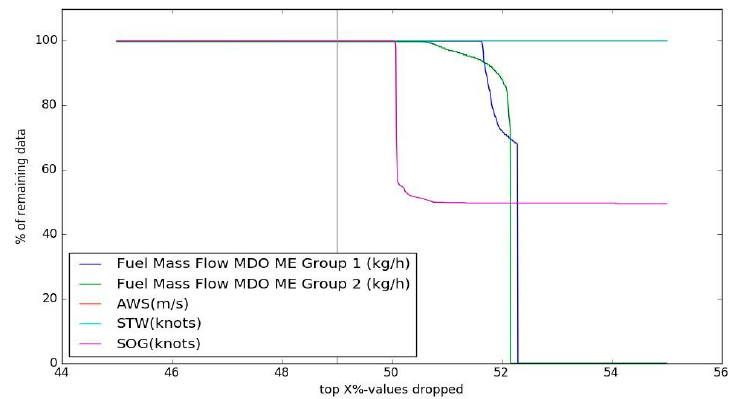
Figure 4. Number of remaining samples per dimension after glitch cut-off.